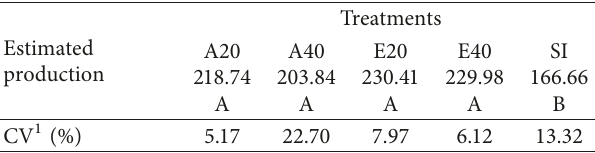
Table 5: Estimation of sugarcane yield (EPC, Mg · ha − 1 ) in the first ratoon.